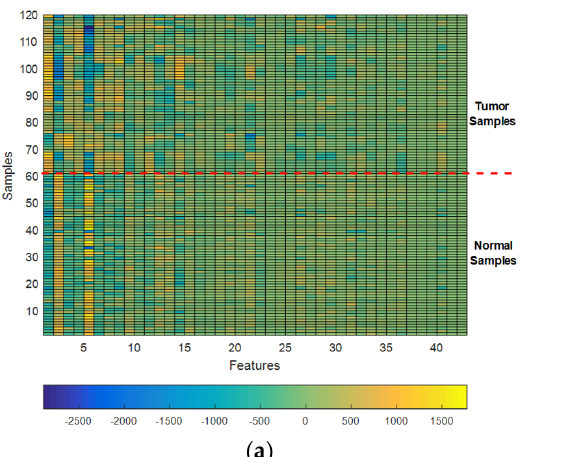
samples as a colormap (Figure 5a) and a surface plot (Figure 5b).